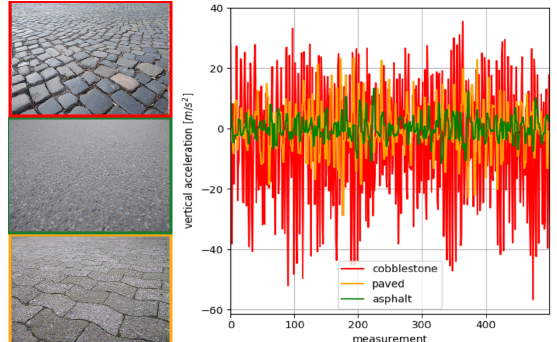
Figure 3. Exemplary acceleration plots for road surface types cobblestone (red), paved (yellow) and asphalted (green).